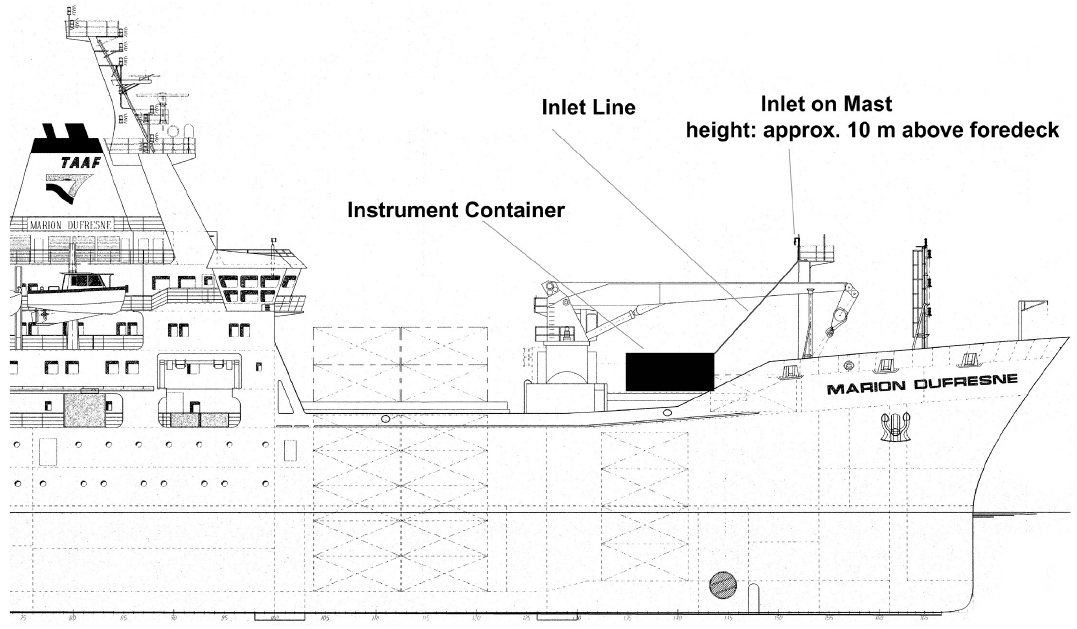
Fig. 3. Schematic of the Marion Dufresne to illustrate the position of the instrument container (black box) relative to the atmospheric mast (Zorn et al.,